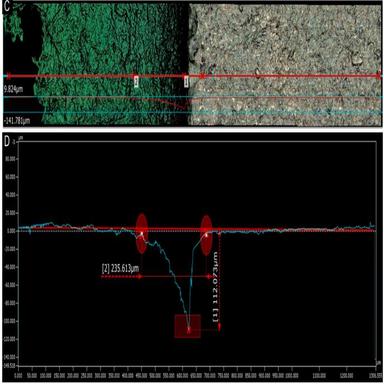
Surface analysis of the interface region between the embedding matrices and the uranium samples. Depth profiles for EPOFIX (A) and clay (C) embedding methods are shown in (B) and (D) respectively. The narrow and shallow interface gap for EPOFIX contrasts with the wide (>200 µm) and deep (>100 µm) gap for clay, leading to contributions of the sample lateral walls to the image shoulder of intensity profiles.